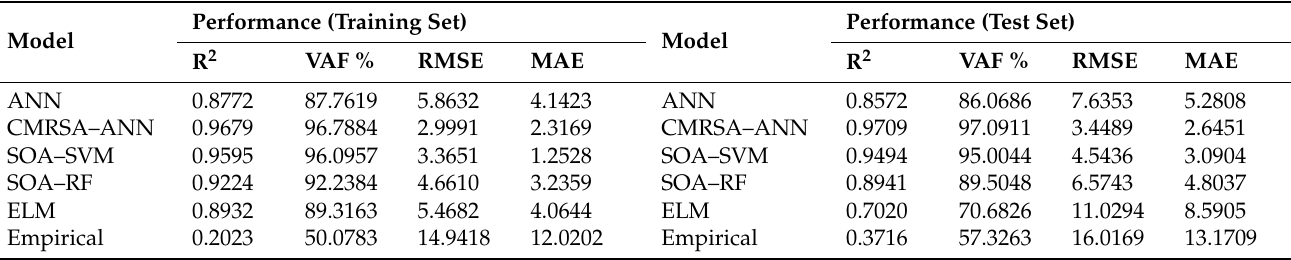
Table 5. Performance evaluation of prediction models using training and test